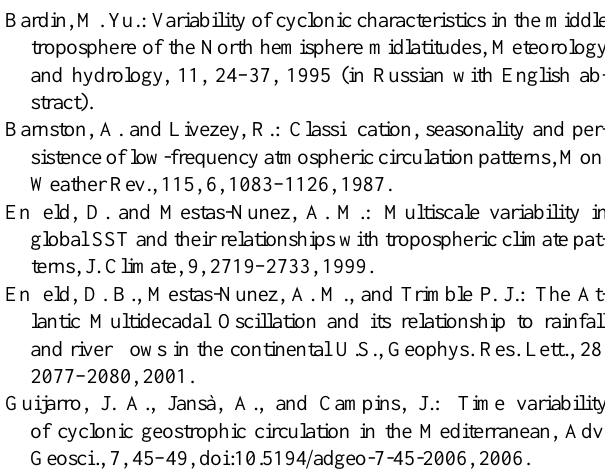
vicinity. Therefore, centers of action of atmosphere in the North Atlantic are weak and the NAO is negative. Figure 6b in the Mediterranean-Black Sea